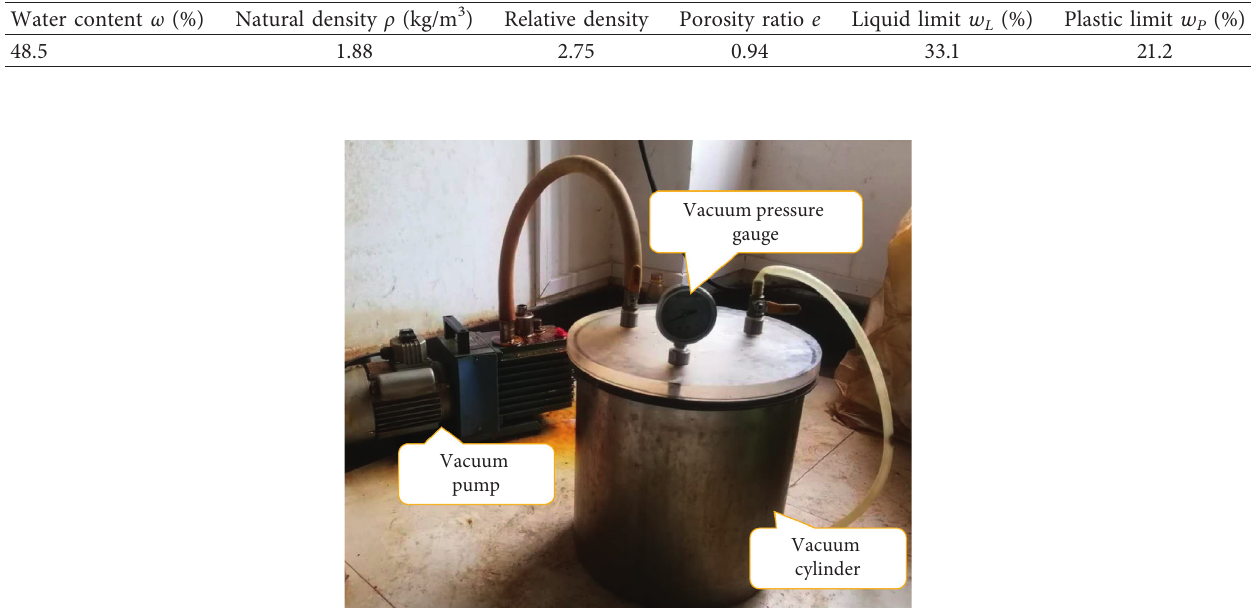
Figure 5: Schematic diagram of sampling location and soil layer information. Table 1: The physical and mechanical properties of soft soil samples.